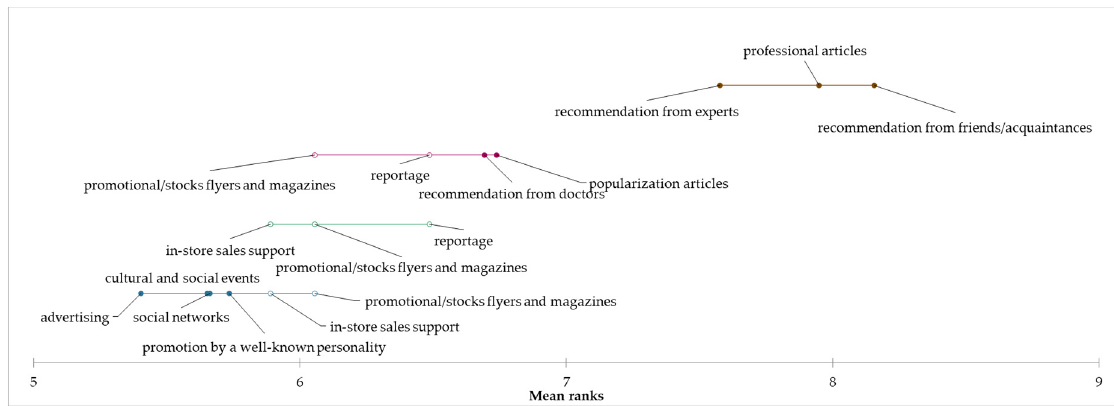
Figure 5. Differences in the evaluation of the influence of information sources on the edible mush- rooms consumption in the “regular consumers” segment.